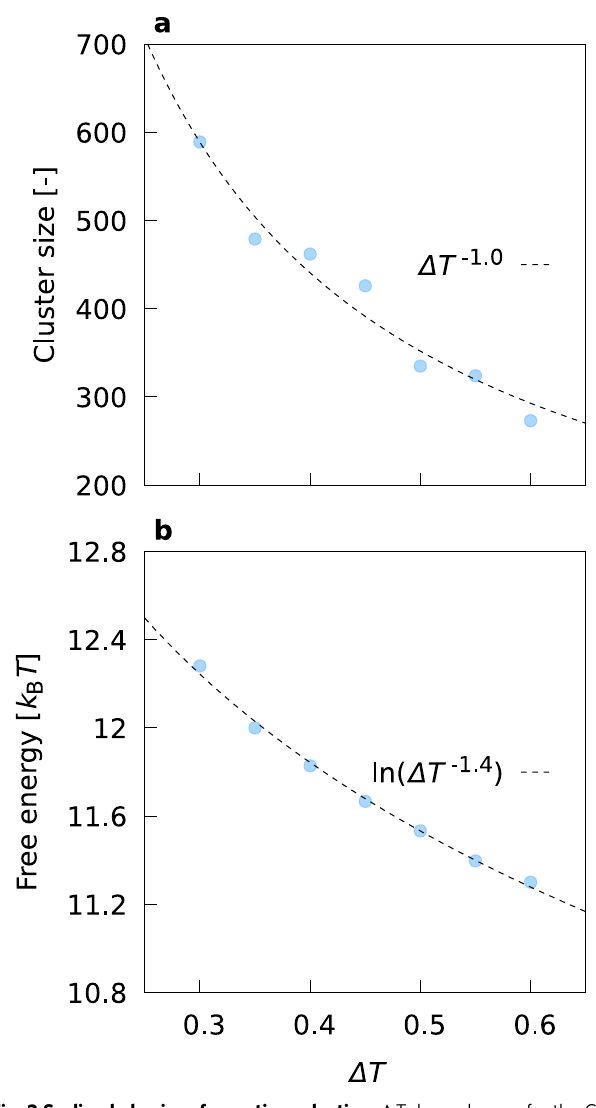
Fig. 2 Scaling behavior of smectic nucleation. Δ T dependence of a the CN size and b the height of the energy barrier from nematic to